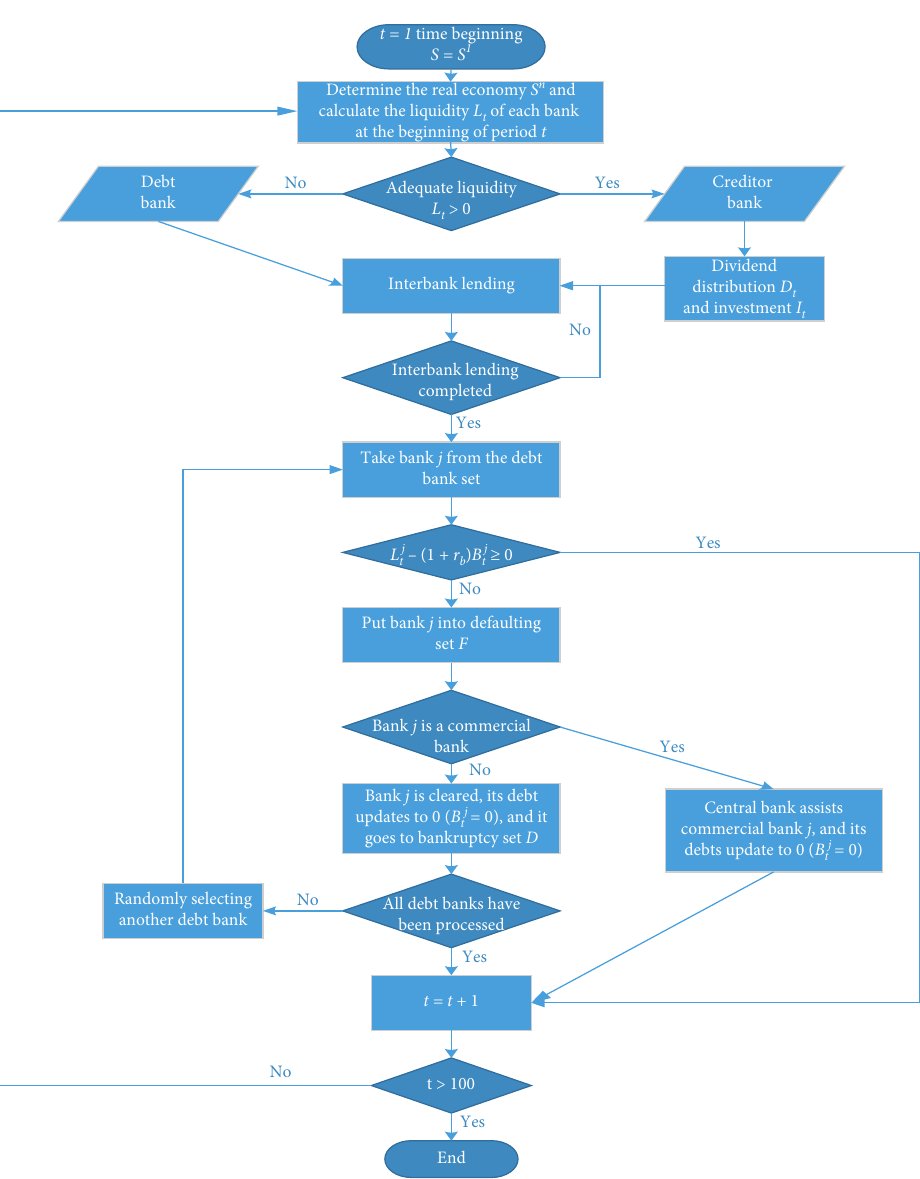
Figure 2: Dynamic process algorithm of the interbank system with shadow